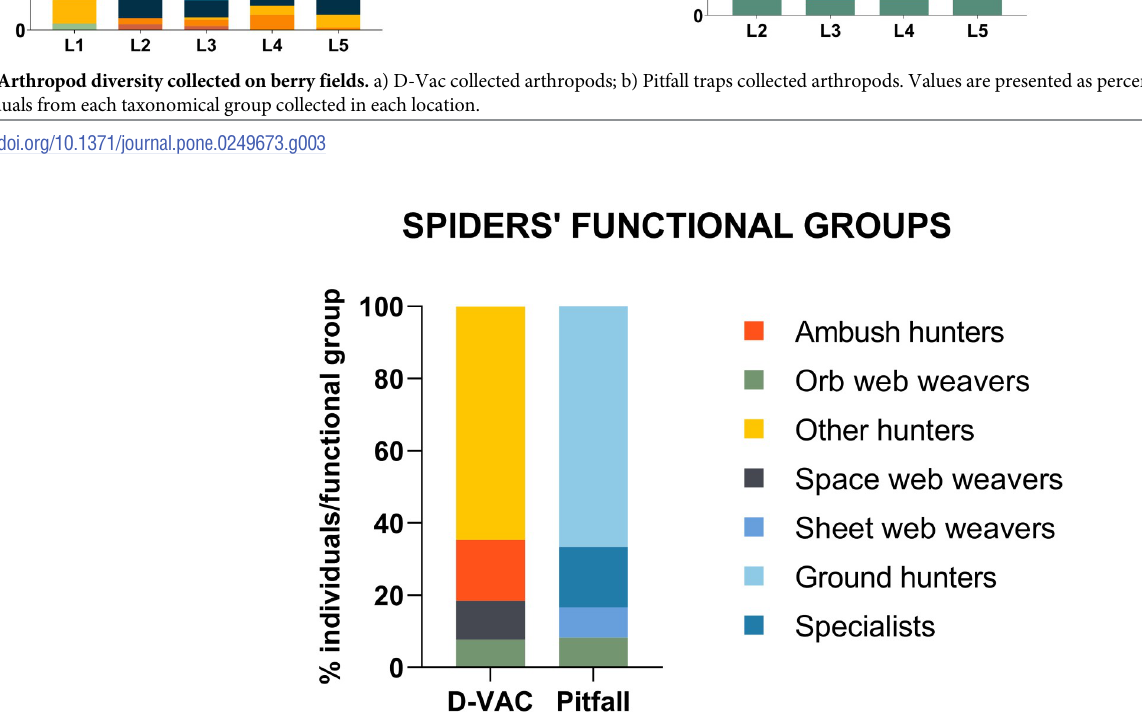
Fig 4. Spiders’ functional group diversity collected with D-Vac and pitfall traps in Portuguese berry fields. Values are presented as percentage of individuals from each functional group collected with D-Vac and Pitfall